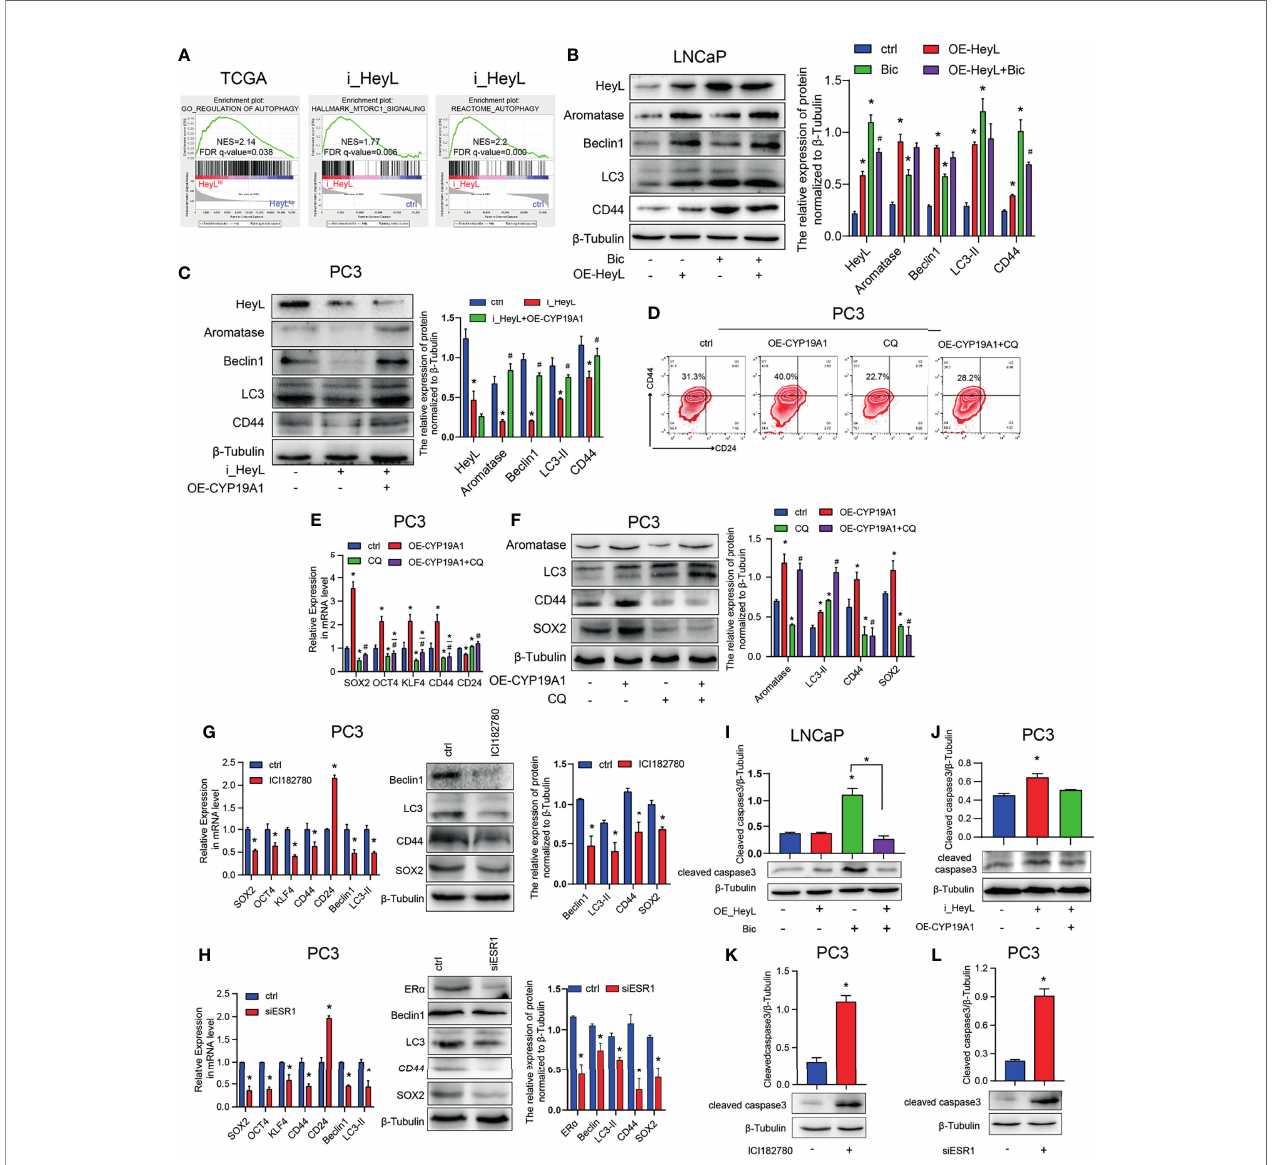
FIGURE 6 | The activated HeyL-aromatase axis promotes autophagic survival of PCSCs. (A) Gene signatures associated with autophagy-associated signaling pathways identi fi ed by GSEA in HeyL High samples vs. HeyL Low samples from the TCGA-PRAD dataset and in HeyL knockdown cells vs. ctrl cells. (B, C) Western blot analysis of Beclin1, LC3, and CD44 in LNCaP (B) and PC3 (C) cells after the indicated treatments. (D) Flow cytometry analysis of the CD44 + /CD24 − subpopulation in PC3 cells treated as indicated. (E, F) mRNA (E) and protein (F) levels of stemness-associated genes and LC3 in PC3 cells after the indicated treatment (one-way ANOVA). (G, H) mRNA and protein levels of stemness-associated genes and autophagy-related genes in PC3 cells treated with ICI182780 (G) and siER a (H) (t-test). (I, J) Cleaved caspase3 levels in LNCaP and PC3 cells after the indicated treatments (one-way ANOVA). (K, L) Cleaved caspase3 levels in PC3 cells treated with ICI182780 (K) or transfected with siER a (L) (t-test). Bic, bicalutamide; CQ, chloroquine. The data are presented as the mean ± SD values (n=3). * p < 0.05 vs. ctrl. # p < 0.05 vs. OE-HeyL, i_HeyL or